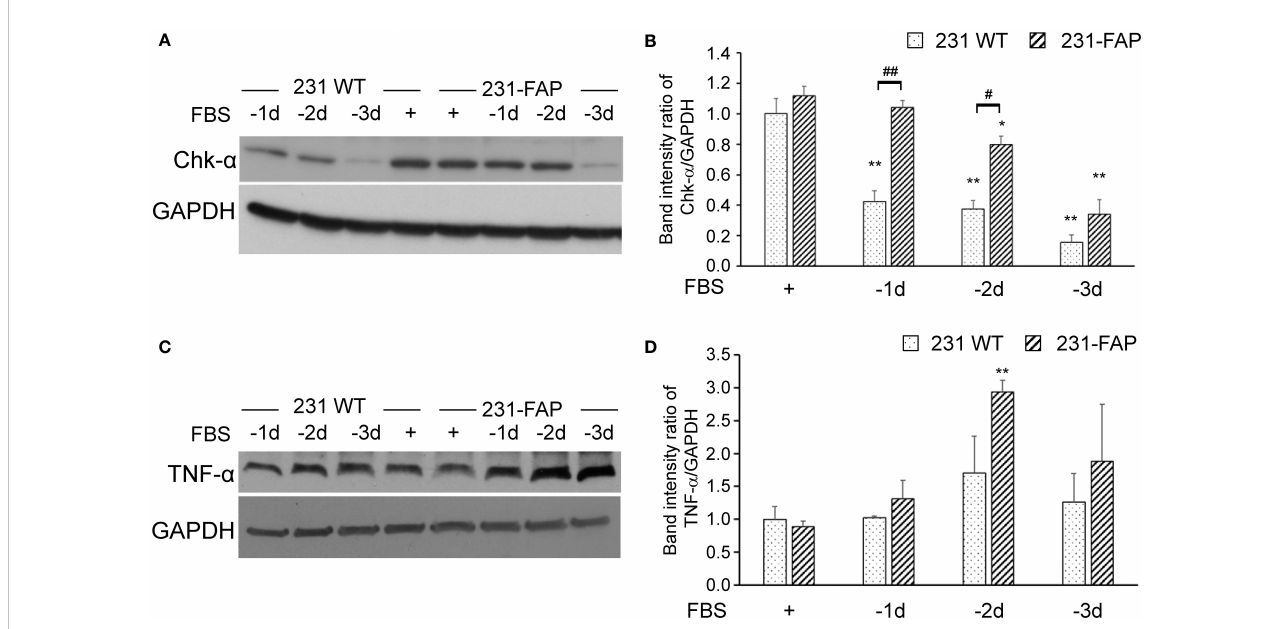
FIGURE 6 Representative immunoblots of (A) Chk- a and (C) TNF- a with GAPDH used as loading control in 231 WT and 231-FAP cells cultured with (+) or without ( – ) FBS. Quantitative analysis of immunoblots represented as band intensity ratio of (B) Chk- a (n = 2-3) and (D) TNF- a (n = 3) to GAPDH, normalized to